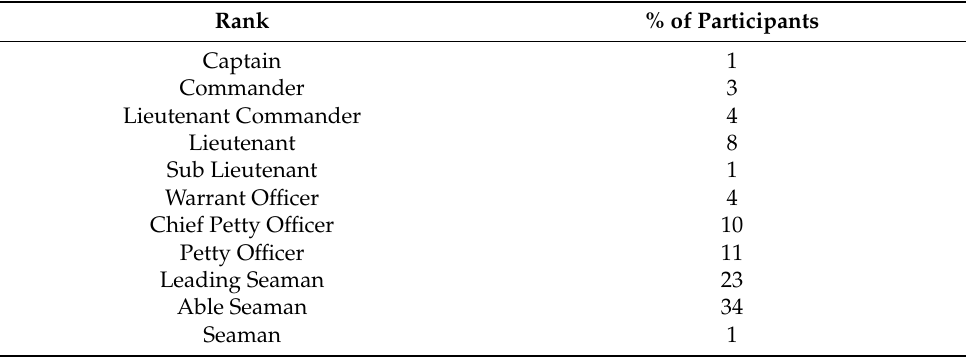
Table 2. Distribution of participant ranks.